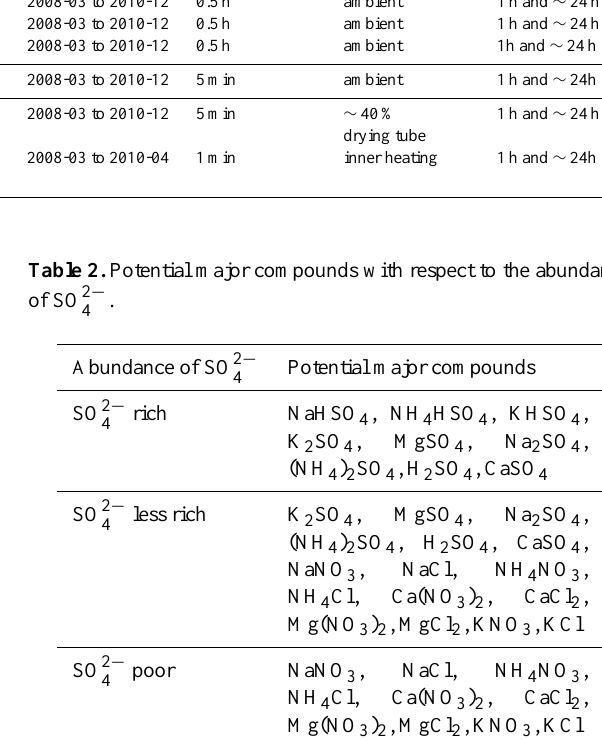
Table 1. Summary of measurement techniques information. Property Instrument Variable Available Particle sampling MSP high-flow cascade im- pactor Chemical analysis